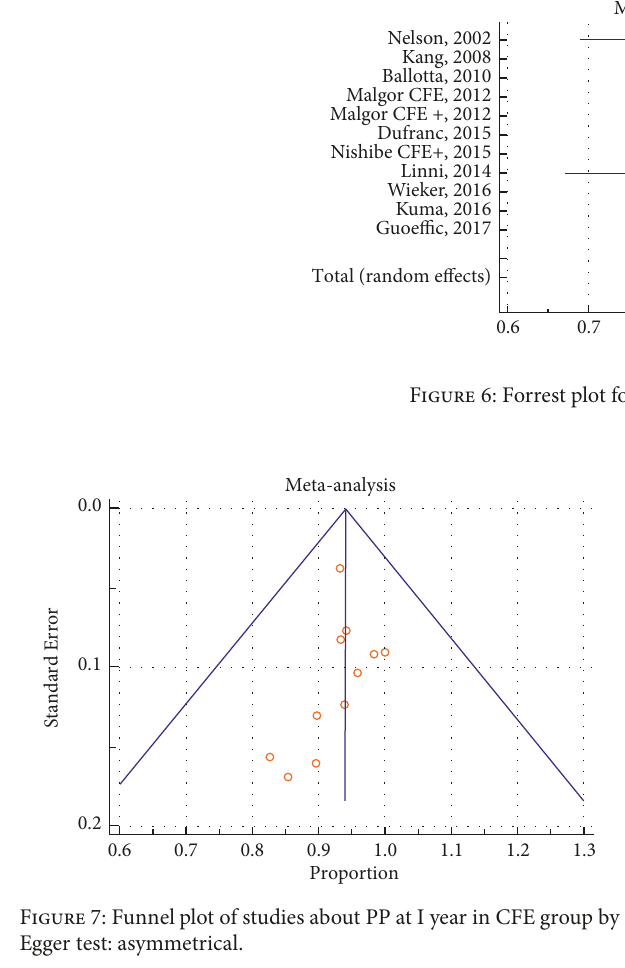
Figure 8: Forrest plot for TLR 1 year in EVT SS group. Figure 9: Funnel plot for TLR 1 year EVT SS group: asymmetrical. Figure 10: Forrest plot for TLR at 1 year in EVT RS group. Figure 11: Funnel plot for TLR at 1 year in EVT RS group: symmetrical. Figure 12: Forrest plot for TLR at 1 year in CFE group. Figure 13: Funnel plot for TLR at 1 year in CFE group: symmetrical. Figure 14: Forrest plot for PP at maximum follow-up in EVT-RS: PP- 83.7% (95% CI 0.74- 0.91). Figure 15: Forrest plot for PP in CFE at maximum follow-up: PP- 88.34% (95% CI 0.81-0.94). Figure 16: Forrest plot for mortality at 30 days in EVT SS group. Figure 17: Funnel plot for mortality 30 days in EVT SS group: symmetrical. Figure 18: Forrest plot for mortality 30 days in EVT RS group. Figure 19: Funnel plot for mortality at 30 days in EVT RS group: symmetrical. Figure 20: Forrest plot for mortality at 30 days in CFE group. Figure 21: Funnel plot for